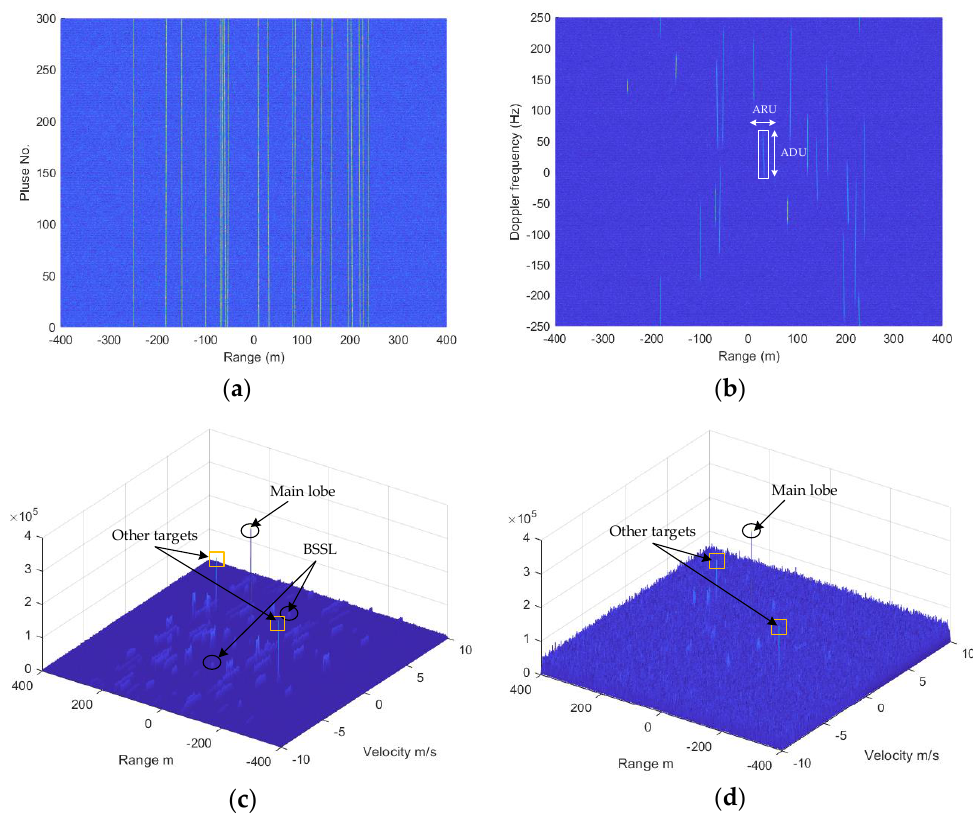
Figure 5. Multiple target simulation—( a ) the received signal after pulse compression; ( b ) moving target detection (MTD) processing result; ( c ) and ( d ) show generalized Radon–Fourier transform (GRFT) results of the same single target in range-velocity domain; SNR = 15 dB for ( a – c ), and SNR = 0 dB for ( d ).